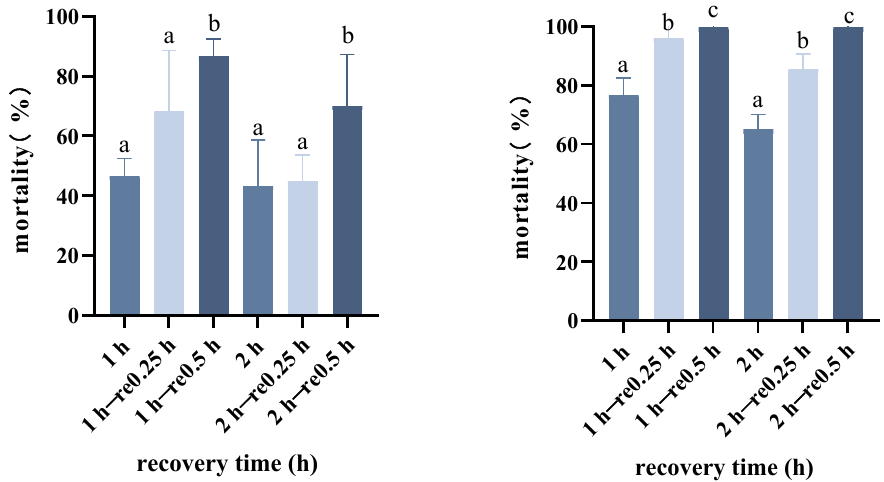
Figure 3. Mortality of Agasicles hygrophila adults exposed to low temperature and subsequent recovery for different lengths of time. Different letters refer significant differences in the mortality of beetles following different recovery times and were analyzed by the LSD test ( p < 0.05). 1 h and 2 h are the treatment times, re − 0.25 h and 0.5 h are the recovery times at 26 ◦ C. All values are presented as the mean ± SE.